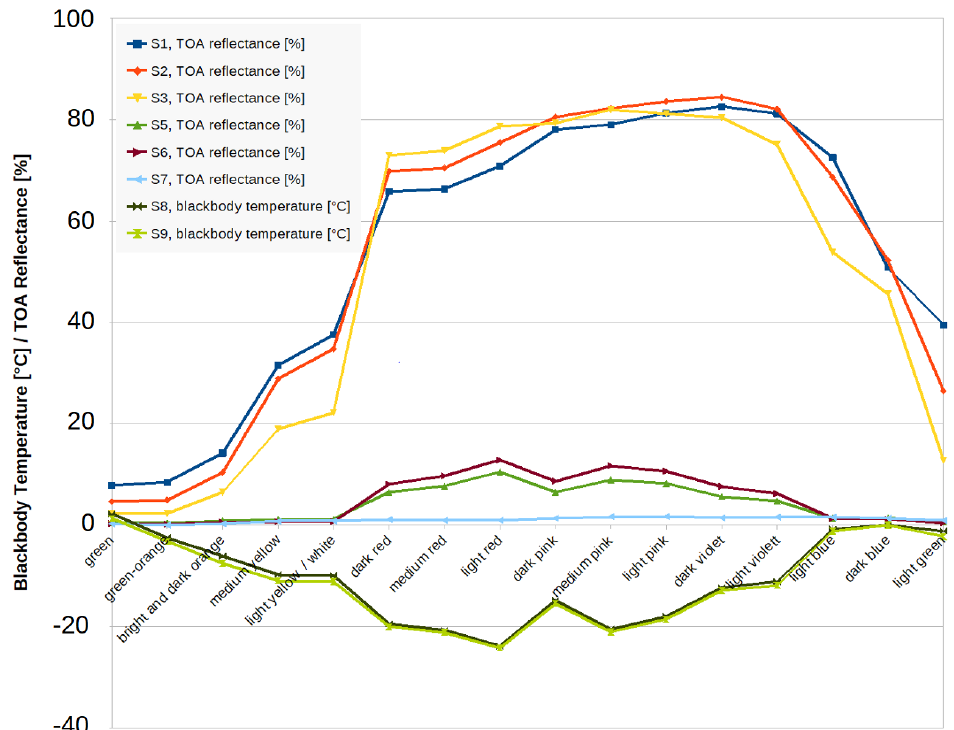
Figure 4. Mean values as measured for top of atmosphere (TOA) reflectance of SLSTR spectral channels S1–S7 and for blackbody temperature equivalent to radiances obtained in channels S8 and S9, for the 16 colours identified as major colours of the SLSTR sea ice classification algorithm. Classes are arranged from left to right in the typical chronology of sea ice formation and decline during an ice season. The determined mean values are connected by line segments to give an impression of intermediate values that occur, e.g., due to mixed pixel contents.